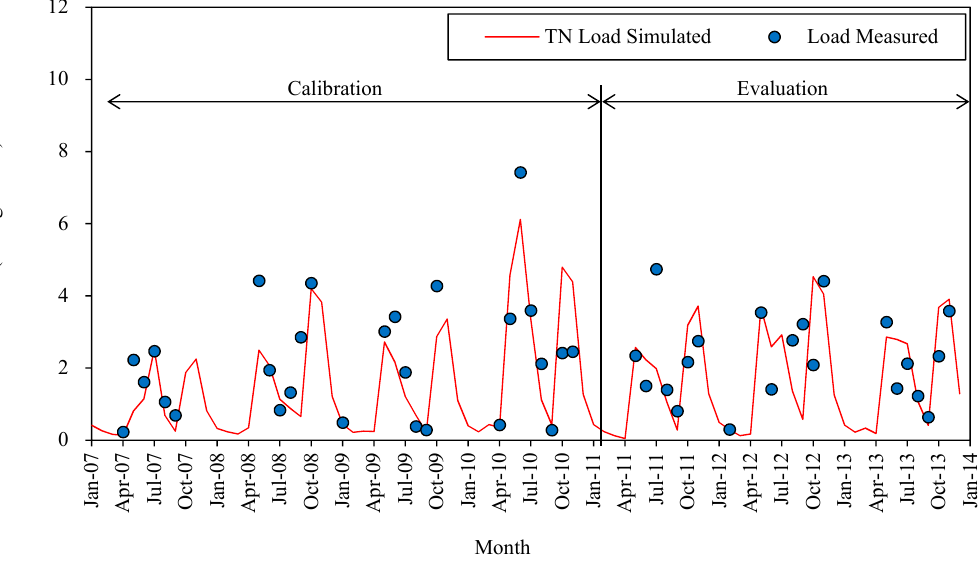
Figure 3. Simulated and measured monthly total nitrogen (TN) load at the outlet.